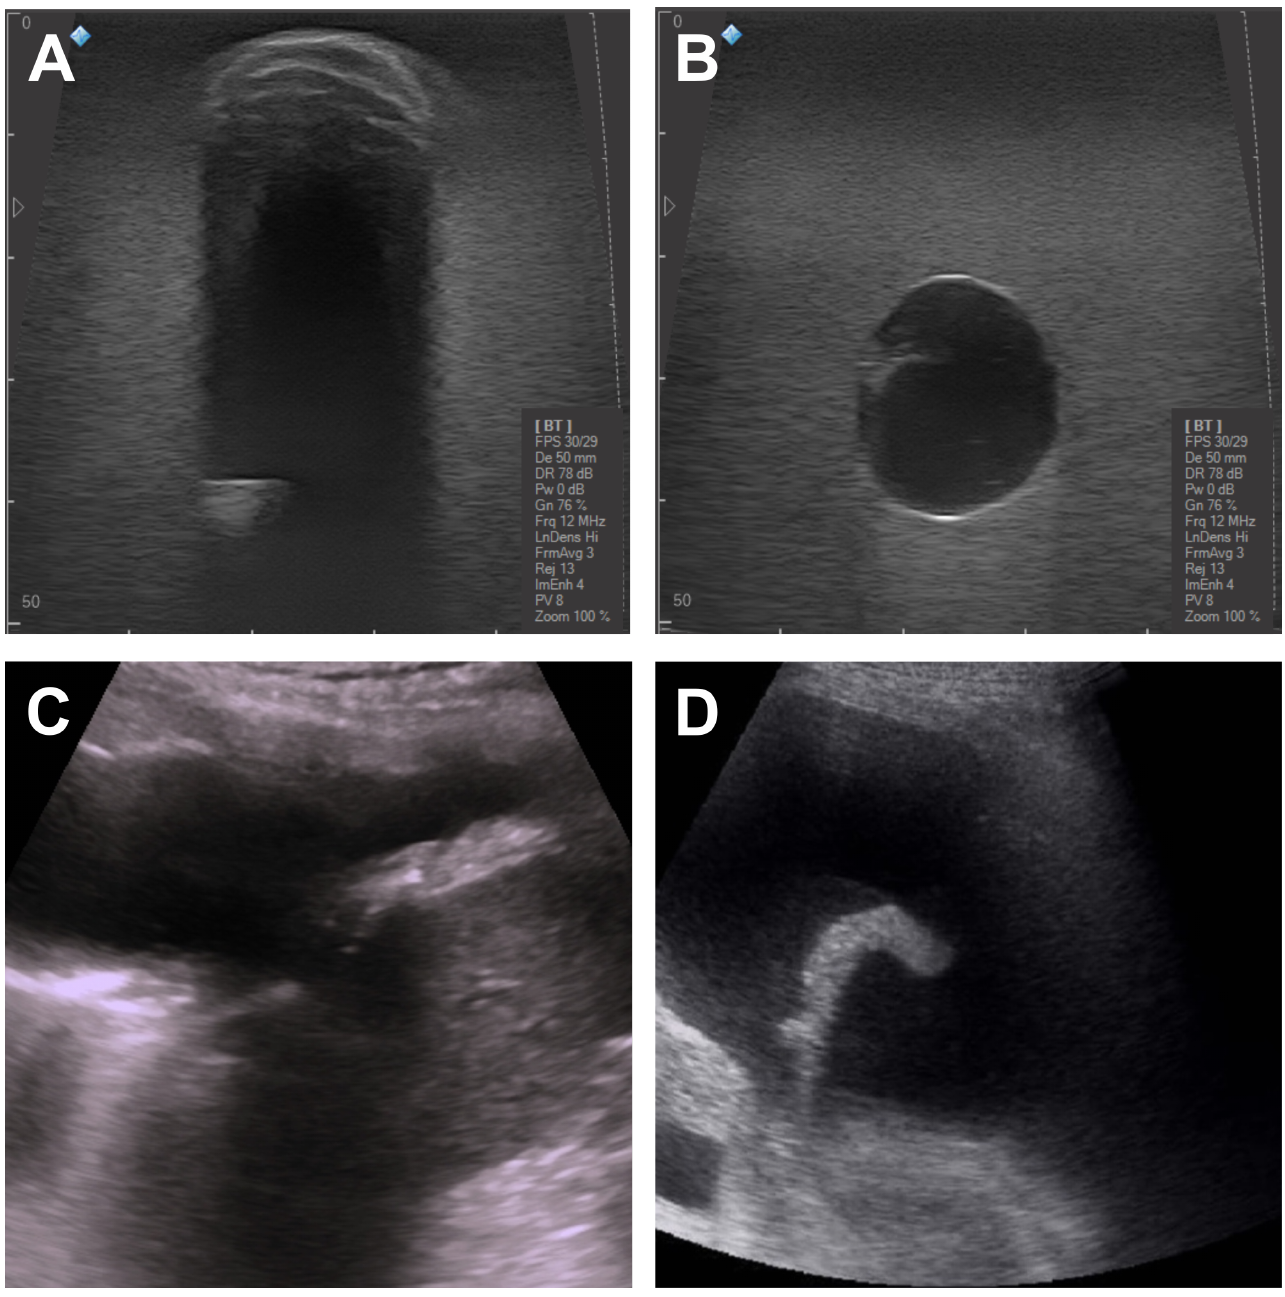
Figure 6. US images of gaseous and liquid inclusions embedded in the PVA-C phantom ( A , B ) as well as real lung ultrasounds ( C , D ). ( A ) An air-filled inclusion and ( B ) a liquid inclusion filled with 0.9% saline solution. ( C ) Lung ultrasound of a subject affected by pleural effusion. ( D ) Pleural effusion with compressive atelectasis of the lung caused by effusion. The details of the acquisition for the images ( C , D ) can be found in